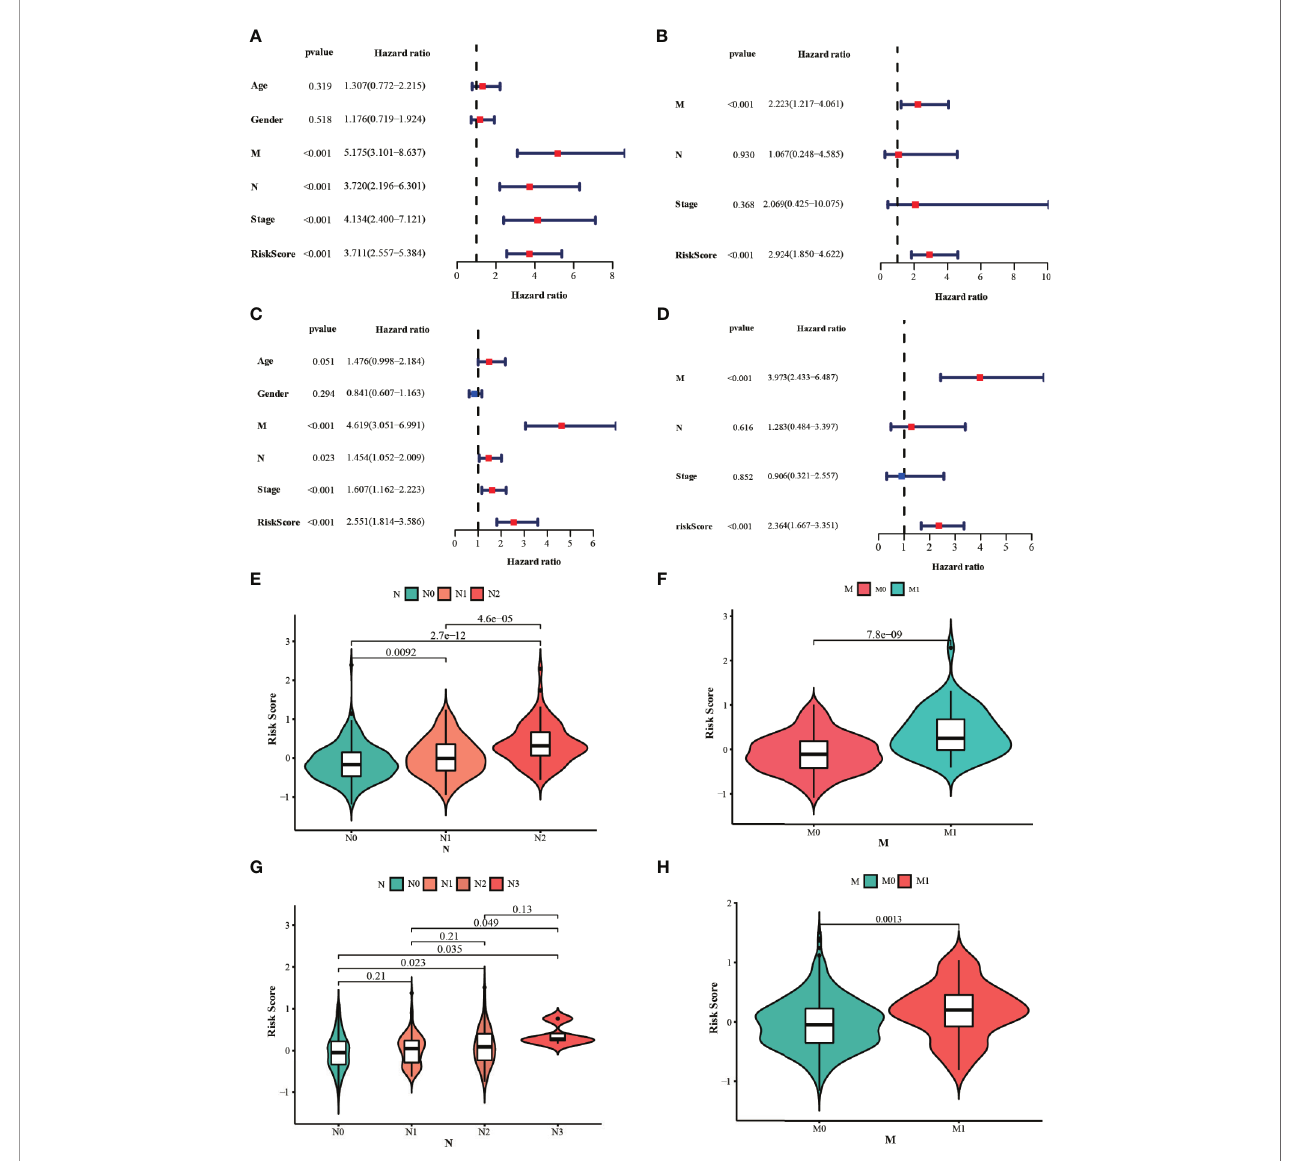
FIGURE 6 | Results of the univariate and multivariate Cox regression analyses regarding OS in the TCGA (A, B) and the GSE39582 (C, D) datasets. The violin plots for the relationships between the risk scores and the clinical indicators (M and N stage) in the TCGA (E, F) and the GSE39582 (G, H)